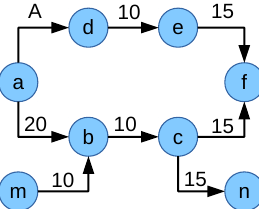
Figure 13. Topology of Scenarios 1 to 4: Two-path connection with shared bottleneck ( b,c ) on the path between a and f . The numbers specify the link speeds in Mbps. scenarios 1,2,4: A = 20; scenario 3: A = 15.